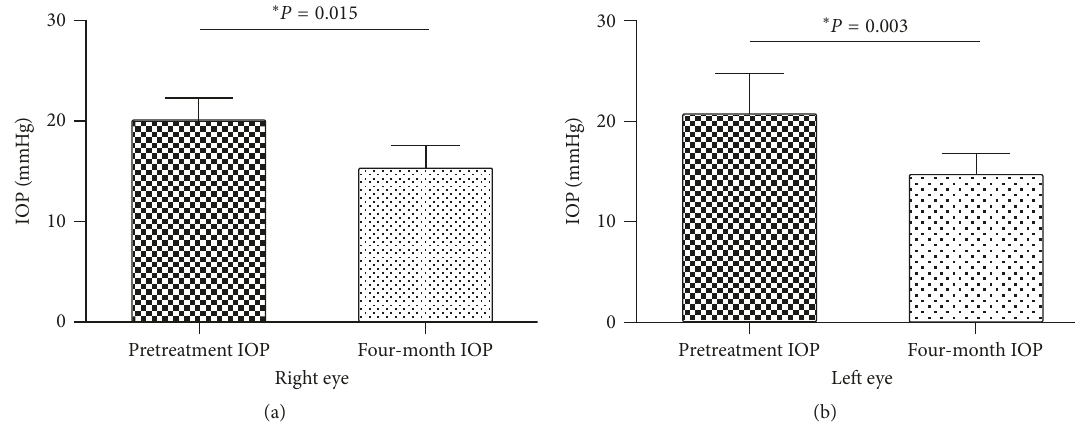
Wilcoxon matched-pairs signed rank test. ∗